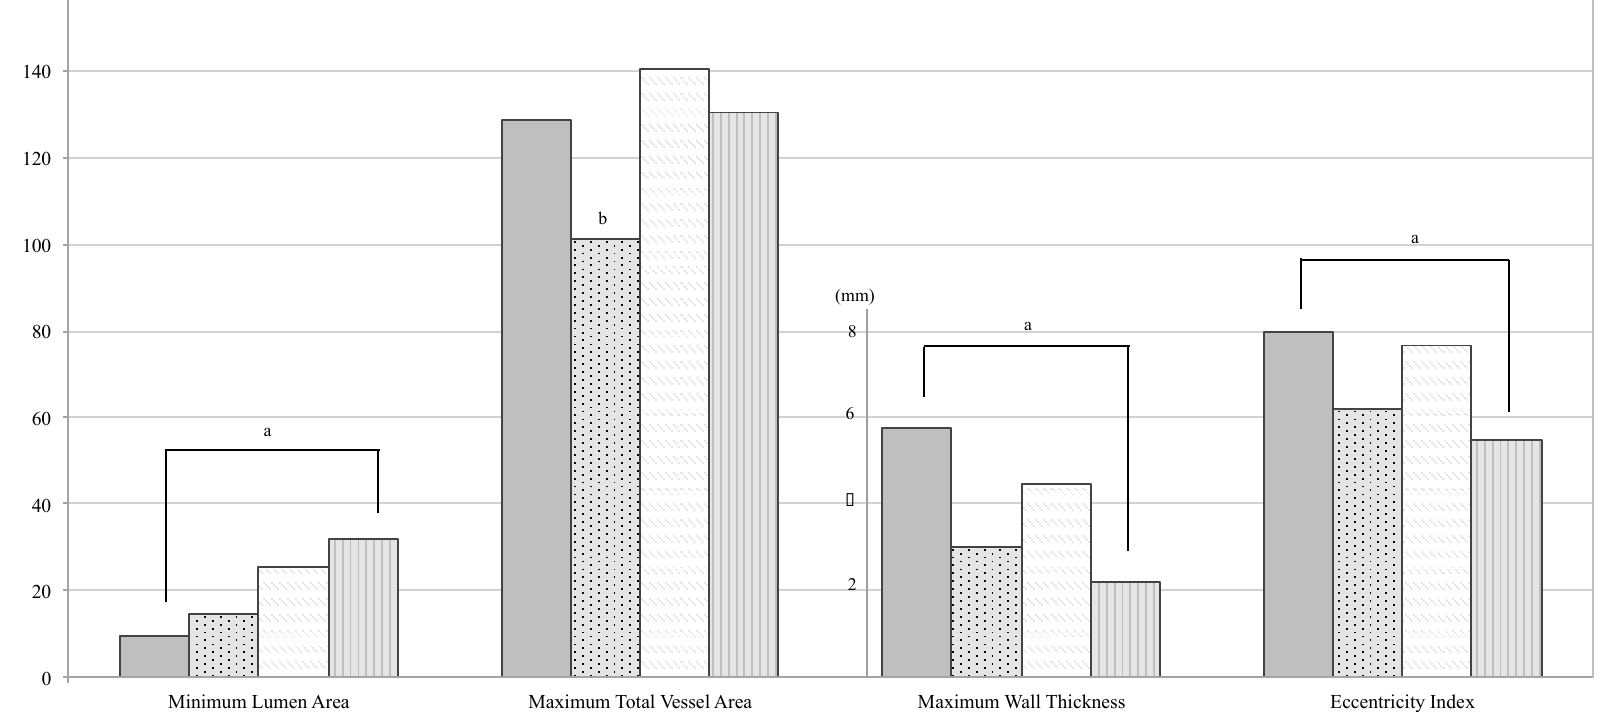
Figure 2. Comparison of plaque morphology between the four groups. a Values were significant di ff erent with each other b Only ss( + ) / HRP( − ) group was significant di ff erent from the other three